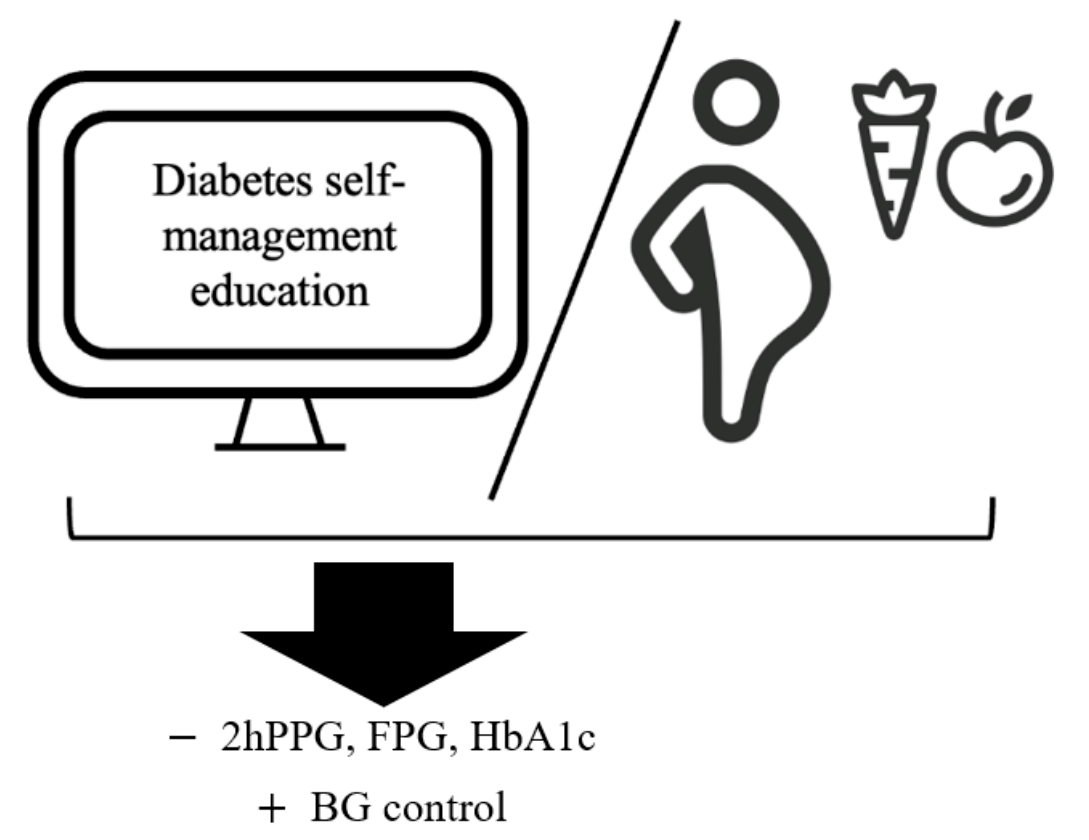
Figure 2. Effects of technology-supported diabetes self-management education and medical nutrition therapy on gestational diabetes clinical endpoints. − indicates reduction; + indicates improvement; 2hPPG: 2 h post prandial plasma glucose; BG: blood glucose; FPG: fasting plasma glucose; HbA1c: glycated hemoglobin.